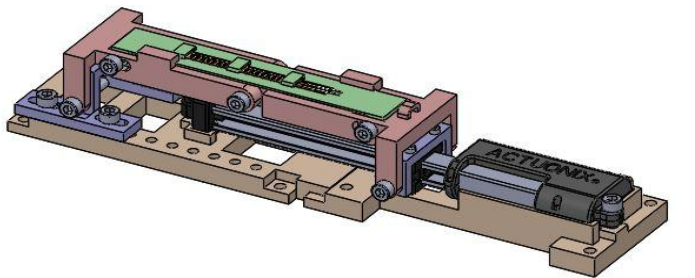
Figure 2. 3D representation of the mechanical structure of the test bench for the characterization of sensors for applications with constant radius of curvature.